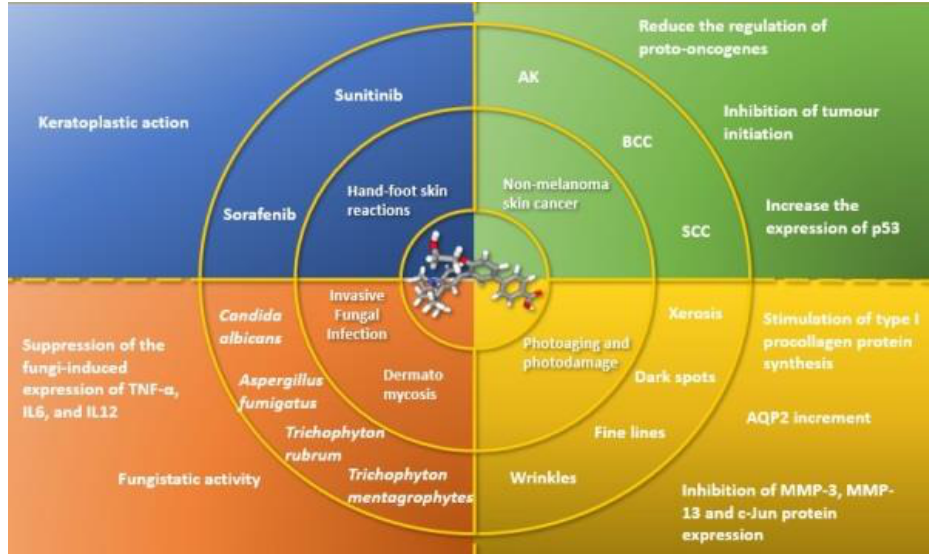
Figure 3. Schematic representation of the perspective applications of trifarotene with a brief ex- planation of the putative molecular